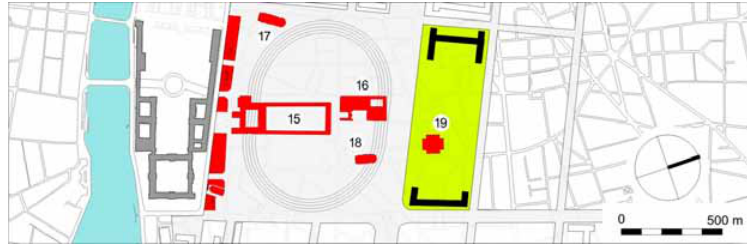
fig. 15. Sector B (Central Station)